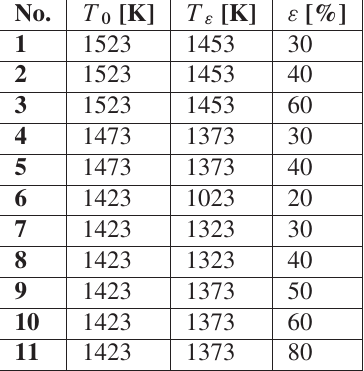
Table 3. Temperature-deformation regime.